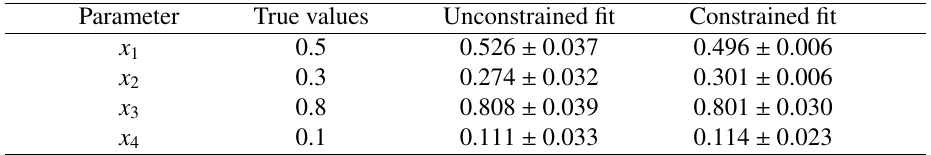
Table 1. Parameter values obtained by fitting the set of events generated according to equation (12), with their